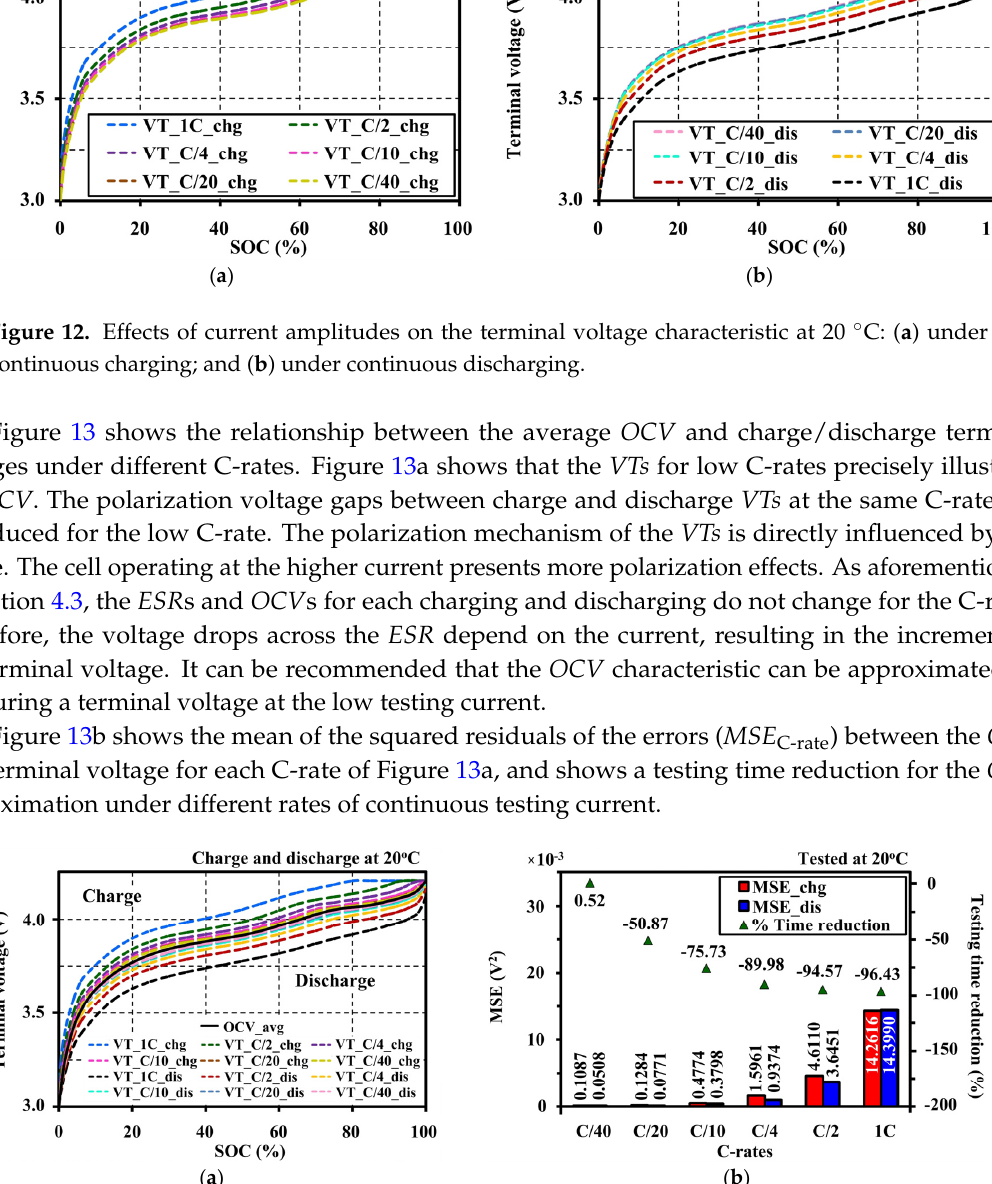
Figure 13. Terminal voltage relationship to the OCV approximation: ( a ) polarization differences of terminal voltages under different rates of continuous testing current on the average OCV ; ( b ) mean of the squared residuals of the errors ( MSE ) and testing time reduction for OCV approximation under different rates of continuous testing current.